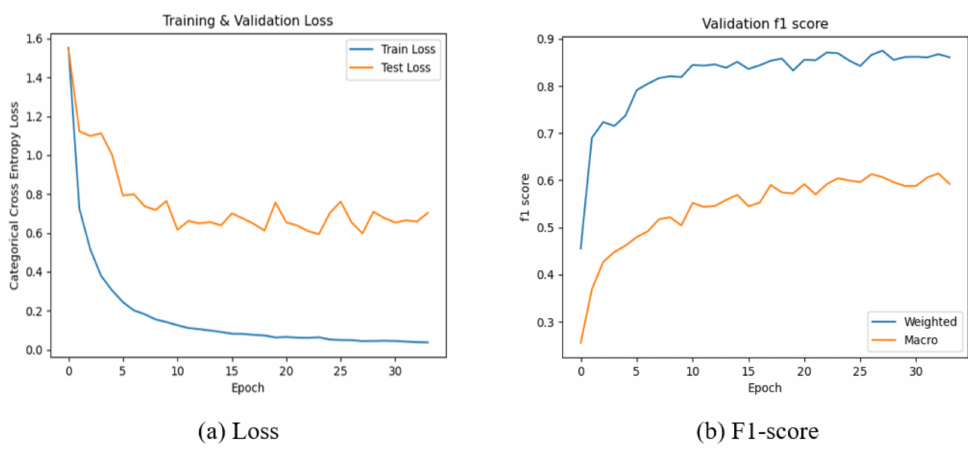
Figure 4. ( a ) Training set distribution, ( b ) validation set distribution, ( c ) test set distribution.